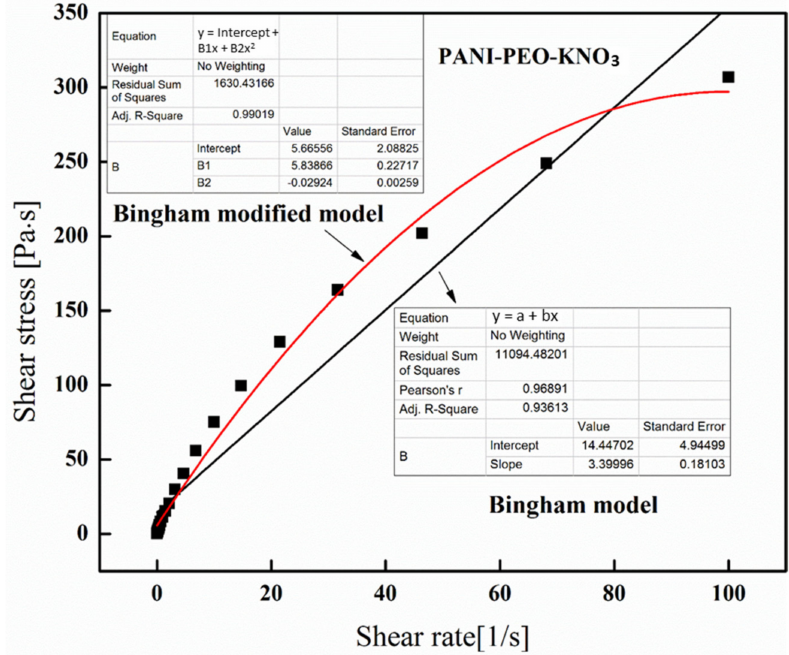
Figure 12. Bingham and modified Bingham models for PANI-PEO-KNO 3 composite at room